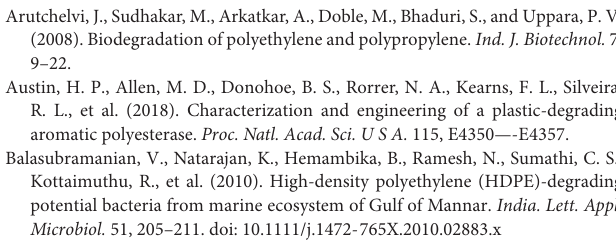
Supplementary Table 3 | A detailed description of filtered reads for mRNA-seq.